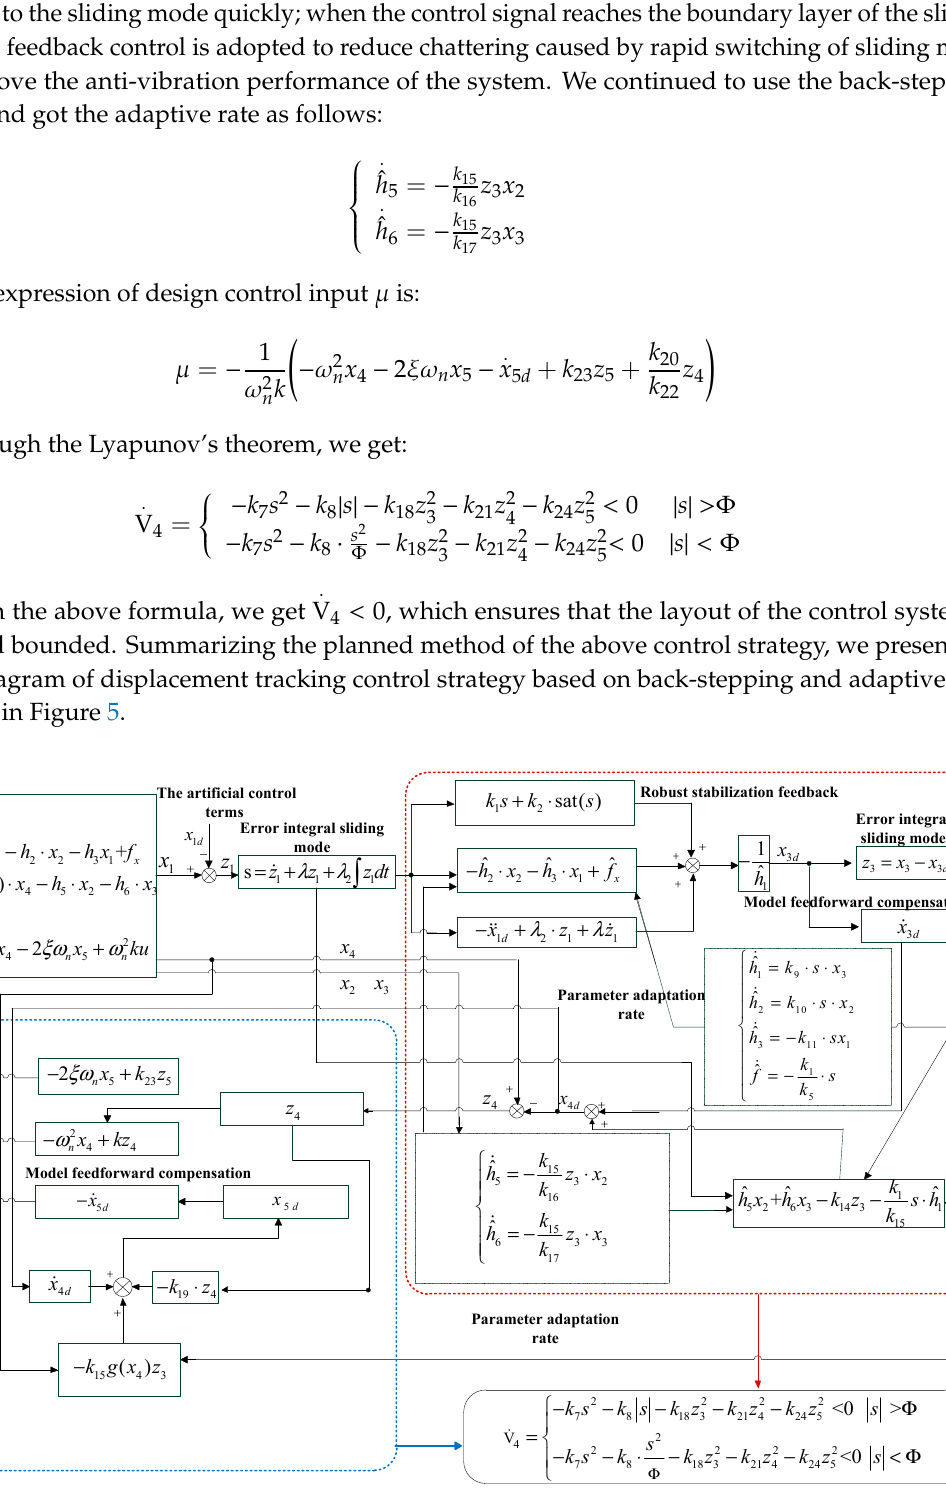
Figure 5. Design diagram of displacement tracking control strategy based on back-stepping and adaptive control methods.